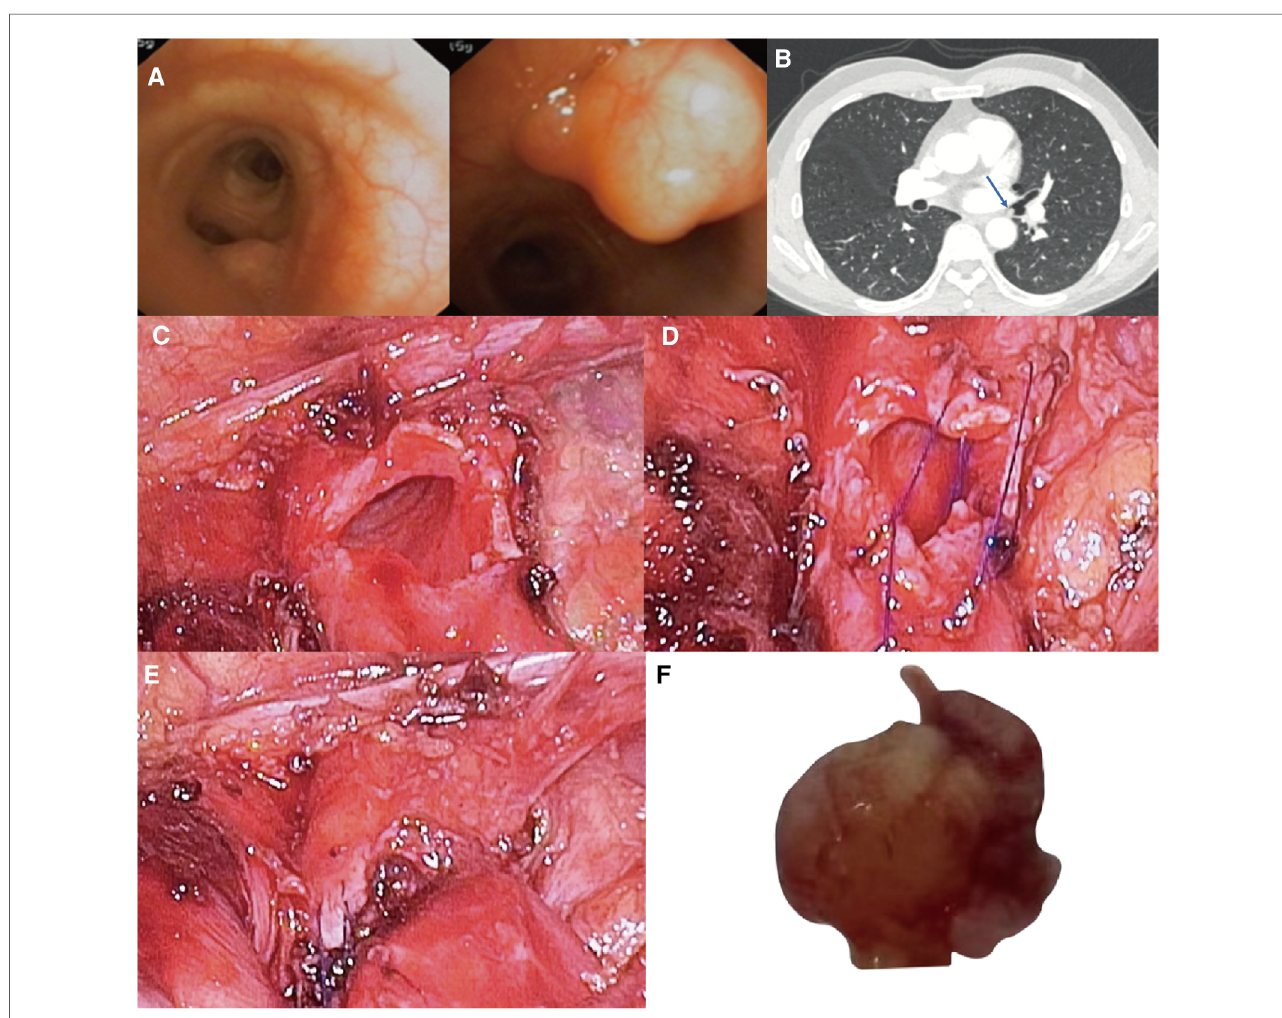
( Figure 1 ) and chest computed tomography (CT) ( Figure 1 ) were performed. At the bronchoscopy, a certain amount of tissue was taken for biopsy, although we found that the tumor was tough and dif fi cult to